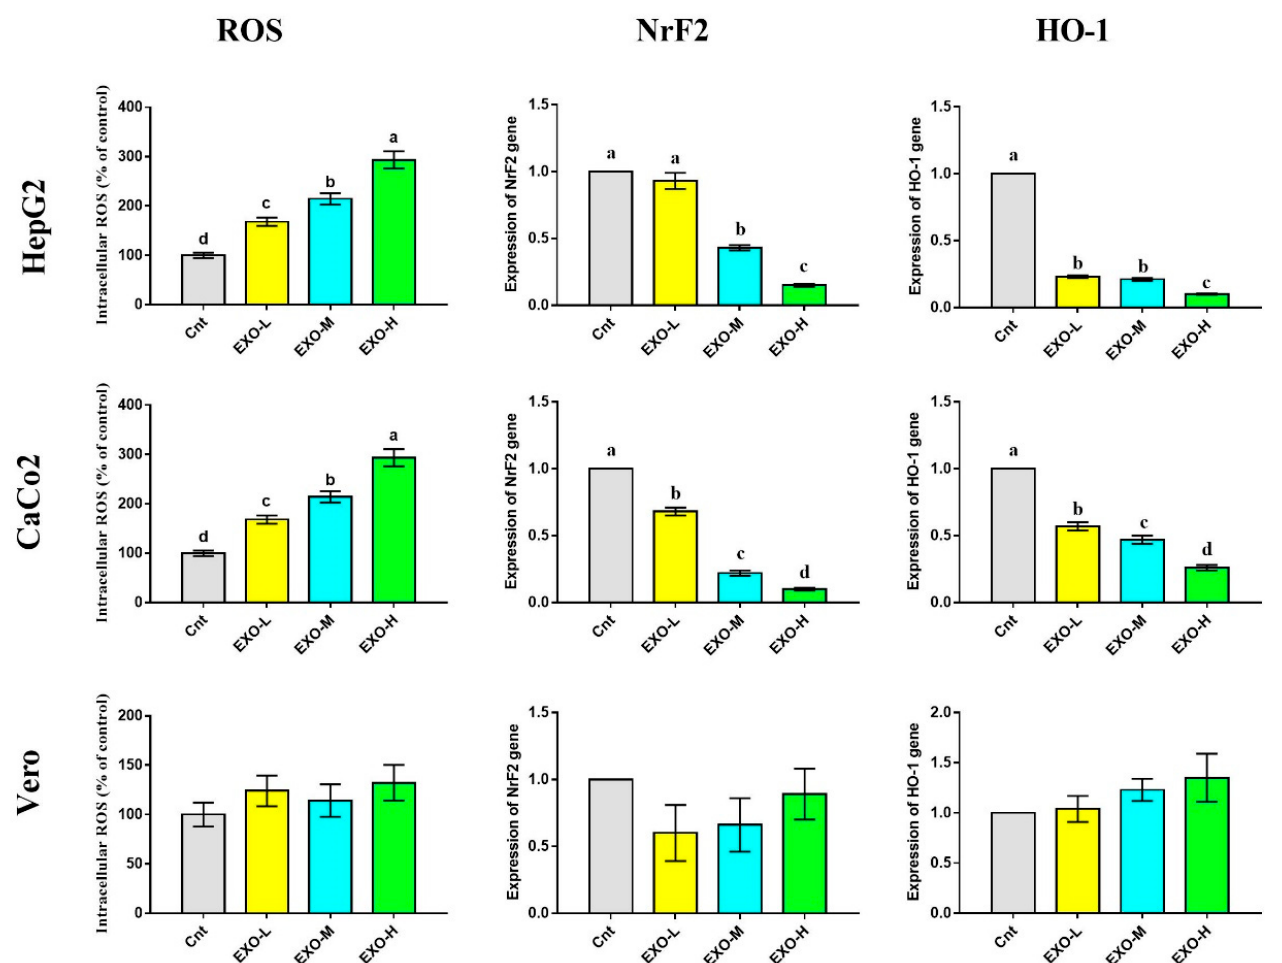
Figure 6. Effect of CM-EXOs on intracellular ROS level and expression of NrF2 and HO-1 as detected by ELISA and qPCR, respectively. Values are expressed as fold change mean ± SEM ( n = 3/group). Columns with different letters are significantly different at p < 0.05. All groups were compared to each other. Cnt, control cells; EXO-L, cells treated with low dose of EXOs; EXO-M, cells treated with medium dose of EXOs, and EXO-H, cells treated with high dose of EXOs.